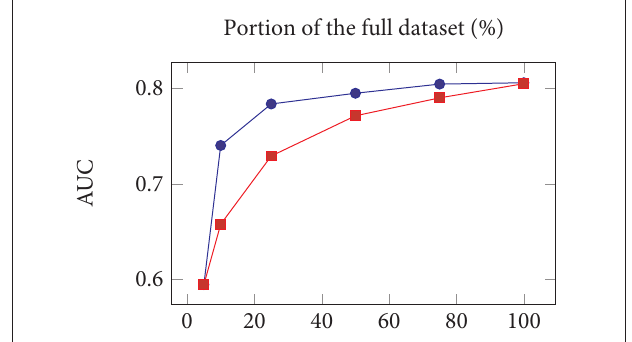
FIGURE 2 | Average performance across the targets of the two best models when only a portion of the training data used.